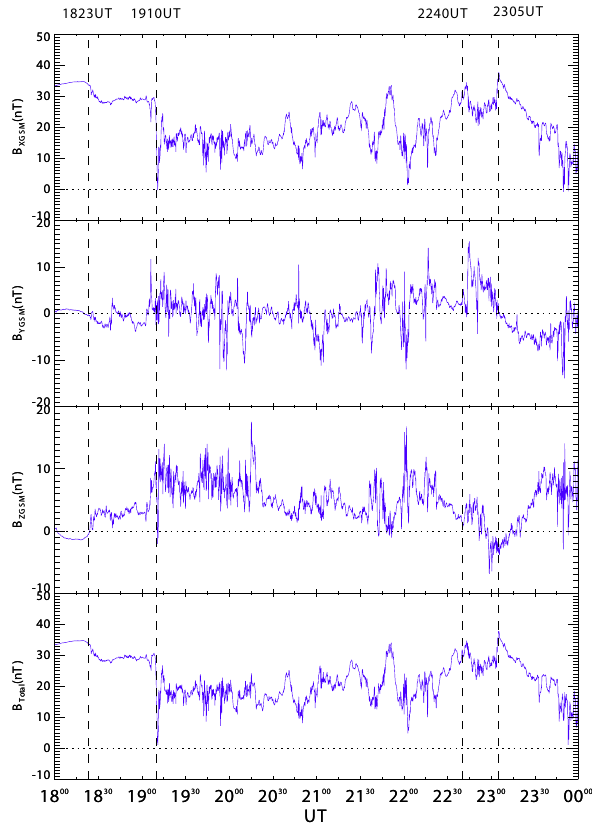
Fig. 11. Cluster FGM data for 1 September 2002 (18:00 to 24:00 UT interval). The B x , B y , B z -components and B total in GSM coordinates are shown for the Cluster 1 spacecraft